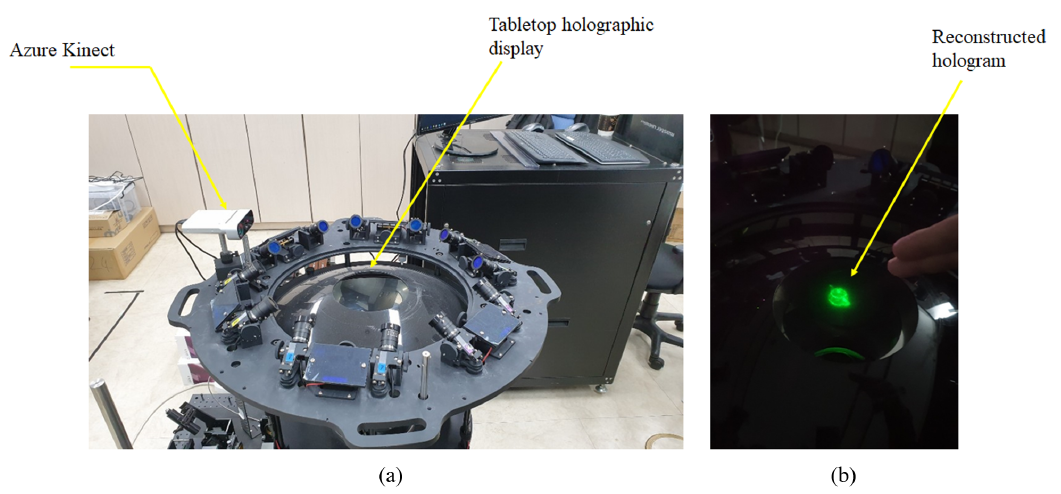
Figure 8. Experiment environment. ( a ) Tabletop holographic environment; ( b ) Gesture interaction